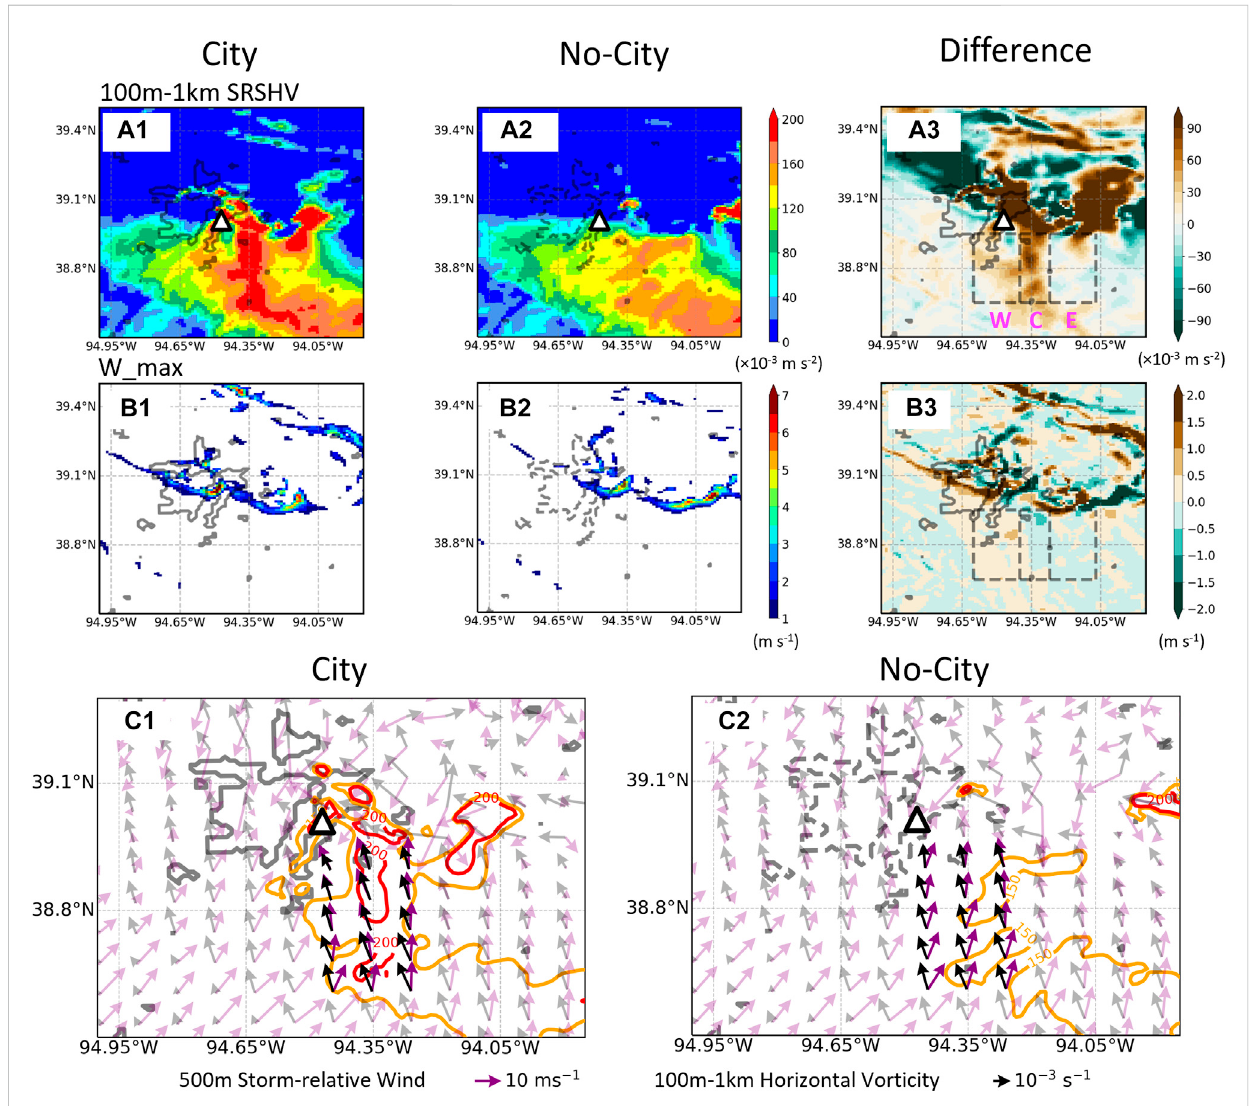
FIGURE 4 Storm-relative streamwise horizontal vorticity (SRSHV) within 100m-1 km for (A1) City, (A2) No-City, and (A3) the difference between City and No- City at 23:30 UTC. (B1 – B3) same as (A1 – A3) except for the maximum vertical velocity below 1 km above ground level (AGL). The composite diagnostic mapsareshownfor (C1) Cityand (C2) No-Citysimulations,wherethe500 mstormrelativewind(purplebarbs)and100m-1 kmhorizontalvorticity(black barbs) are overlaid on the SRSHV (contour). Note that barbs within the in fl ow region of area C are